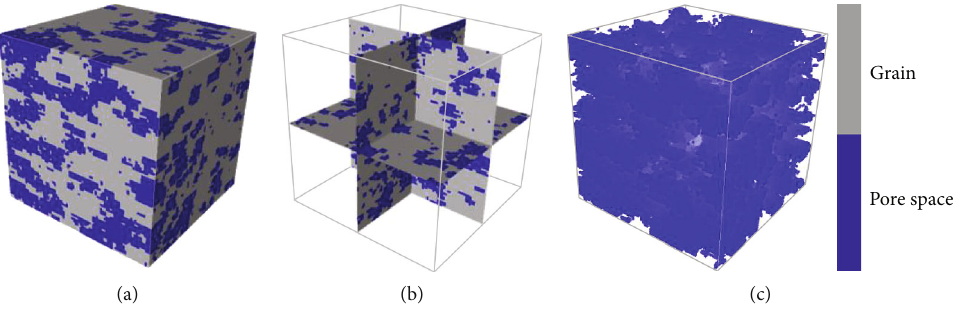
Figure 9: The target image of shale: (a) exterior; (b) cross-section ( X = 40 , Y = 40 , and Z = 40 ); (c) pore